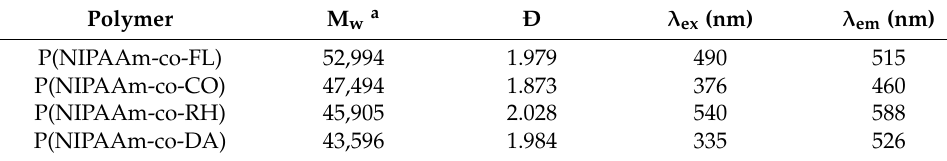
Table 1. Characterization of synthetic FPs. Reproduced from reference [82].